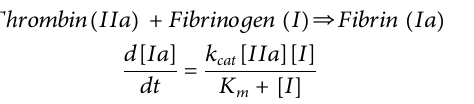
Frontiers in Physics |